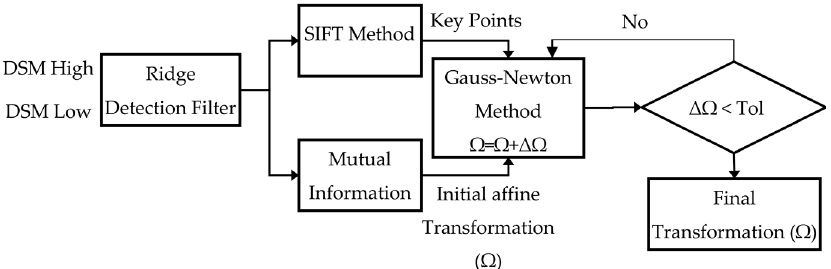
Figure 5. Digital surface model (DSM) co-registration: flowchart of the adopted method (SIFT is the Scale Invariant Feature Transform method and Tol is tolerance.)